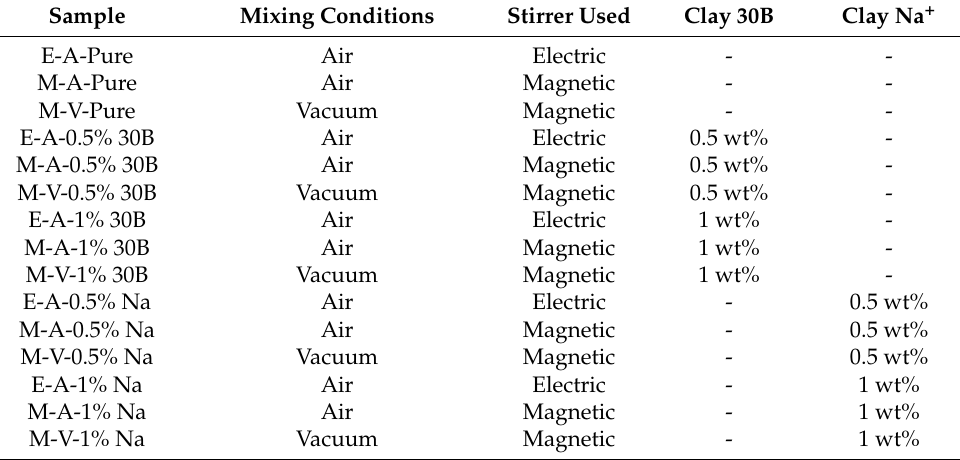
Table 4. Experimental details, compositions, and nomenclature of all the samples in the